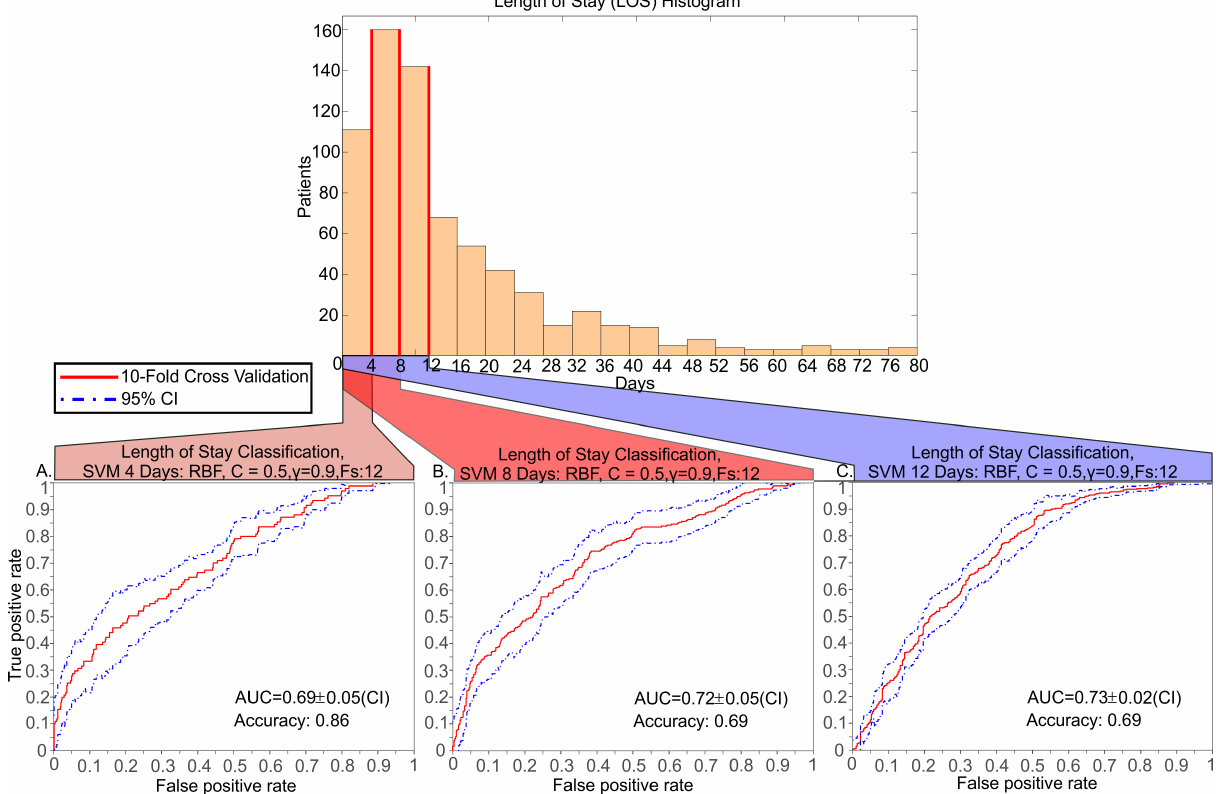
Figure 7. Predicting a patient’s Length of Stay (LOS). Histogram of the LOS for the 745 patients in the database that have a complete record (median length of stay is 10.4 days). ROC curves for binary classifiers when 4, 8 or 12 days was used as the boundary between the two